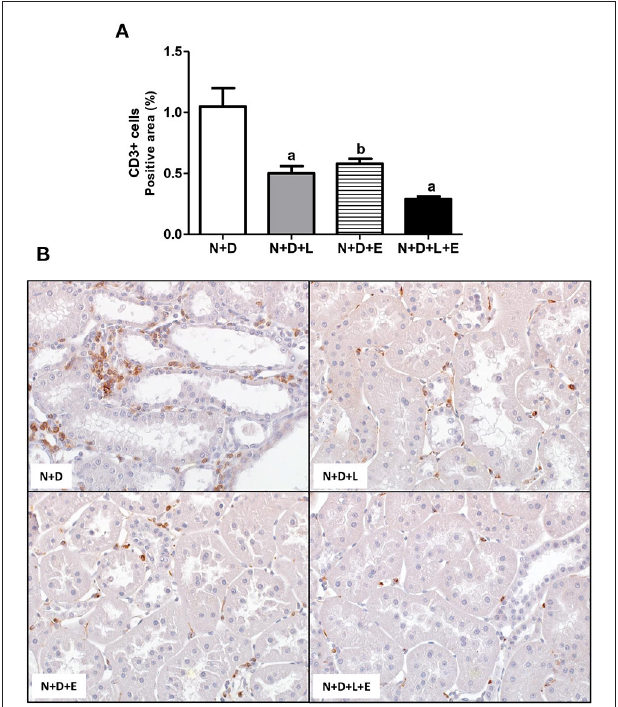
FIGURE 10 | Immunohistochemical analysis of CD3 + cells (T cells) in the renal cortex. (A) Bar graph of CD3 + cells expression evaluated 60 days after 5/6 nephrectomy in vitamin D-deficient rats treated with losartan, erlotinib or losartan + erlotinib. (B) Representative photomicrographs of immunostaining for CD3 + cells in the renal cortex from a N + D, N + D + L, N + D + E, and N + D + L + E rat (x400). Data are mean ± SEM. a p < 0.001, b p < 0.01 vs. N + D. N, 5/6-nephrectomized rats; D, vitamin D-deficient rats; L, losartan-treated rats; E, erlotinib-treated rats; L + E, rats concomitantly treated with losartan + erlotinib. N + D ( n = 10); N + D + L ( n = 8); N + D + E ( n = 7); N + D + L + E ( n = 10).